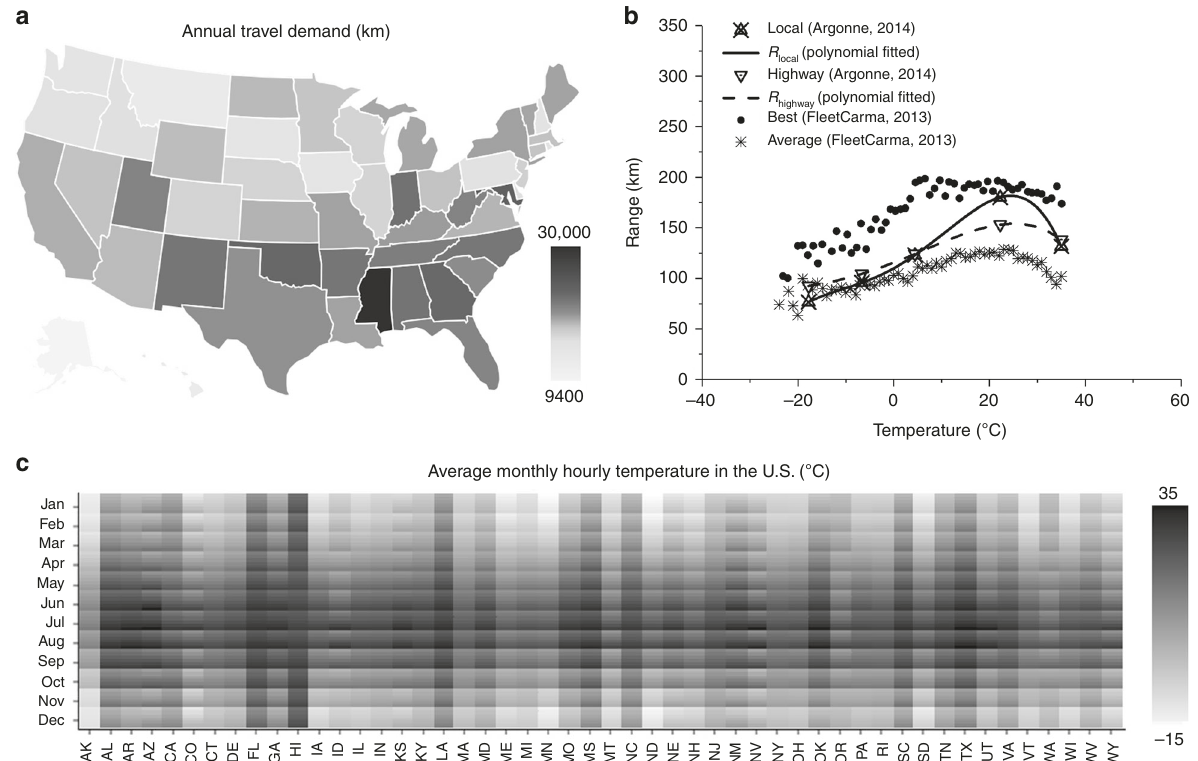
Fig. 1 Average state-level operating conditions and initial driving ranges for electric vehicles in the US. a Annual travel demand of each state ranging from 9399 km in Alaska to 29,871km in Mississippi 25 , drawn with Plotly 46 . b Initial driving ranges of Nissan Leaf under different ambient temperatures and driving patterns 30, 31 ; R local and R highway are the driving range of electric vehicle under local and highway driving conditions, respectively, the fi tted driving range equations are shown in Eqs. (3) and (4) in Methods section. c Monthly – hourly average temperature in each US state during 1981 – 2010 period, ranging between − 15 and 35 °C